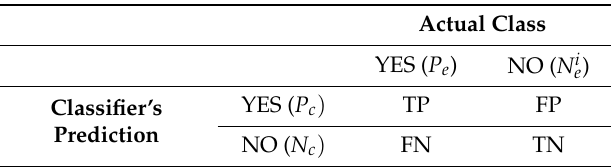
Table 1. Summary of prediction